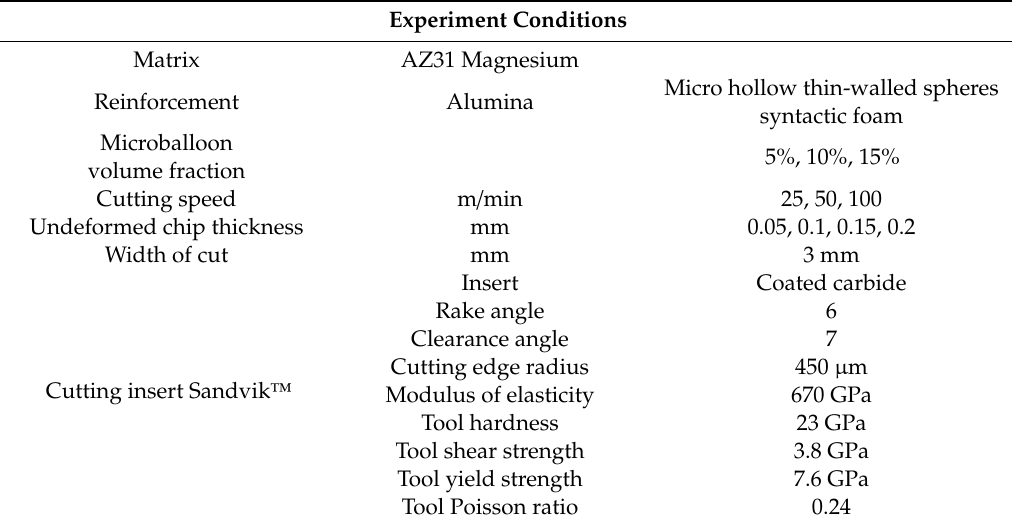
Table 3. Conditions for cutting tests.